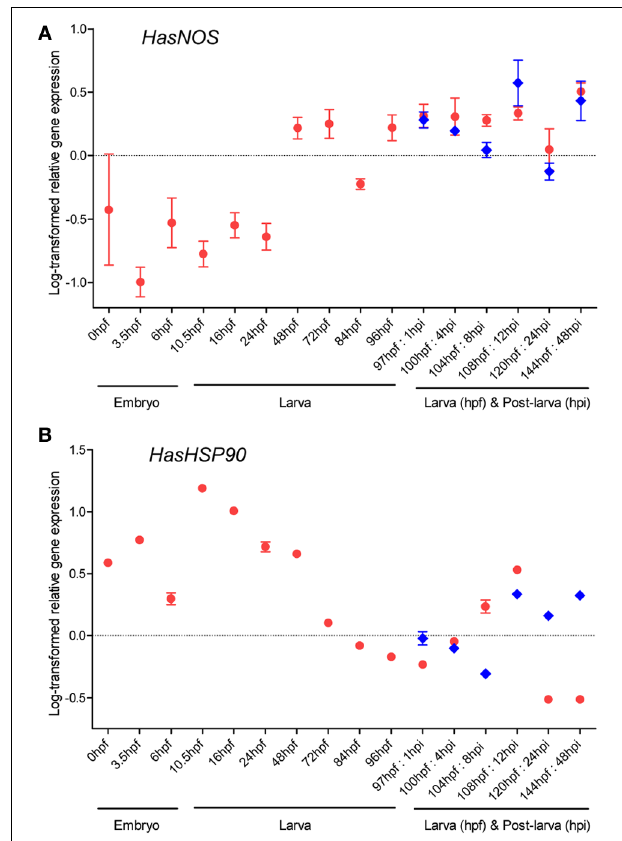
FIGURE 5 | HasNOS (A) and HasHSP90A (B) gene expression through H. asinina normal development. Transcript abundance was assessed by qRT-PCR using mRNA purified from a pool of ∼ 1000 embryos or larvae for each developmental stage (red circles). Transcript abundance in pooled samples of post-larvae induced by coralline algae Amphiroa ephedraea is denoted by blue diamonds. Data are presented as log-transformed mean ± s.e.m. of three technical